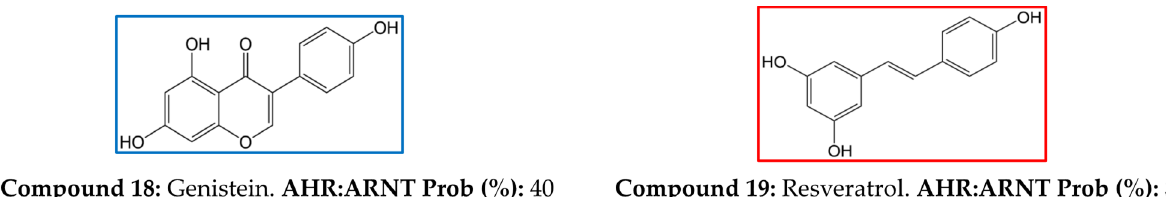
Figure 5. Genistein and resveratrol, with the probability of blockage.